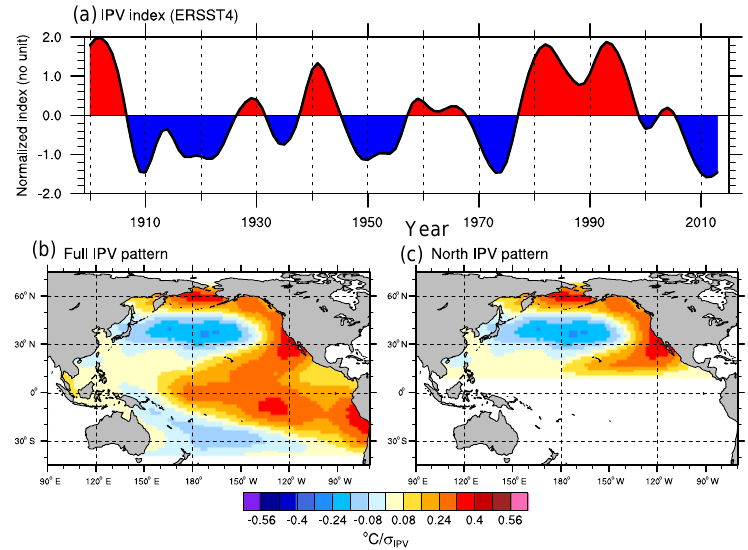
Figure 7. Idealized Pacific SST patterns. The time series (upper panel) and pattern (lower panel) are derived following the procedure documented in Ting et al. (2009) using ERSSTv4 (Huang et al., 2015) as discussed in Technical Note 1 (available from the DCPP website at http://www.wcrp-climate.org/dcp-overview). Experiments C1.4 to C1.6 use the full IPV pattern (lower left panel), whereas experiment C1.9 applies the anomalies in the northern extra-tropics (lower right